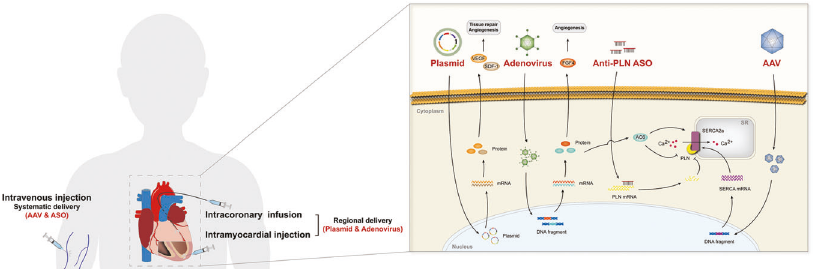
Fig. 5 Summary of therapeutic strategies based on gene therapy for failing hearts. Early attempts were plasmid and adenovirus based. These reagents are usually locally delivered by intracoronary infusion or intramyocardial injection. The overexpressed genes encode secretory protein related to angiogenesis and tissue repair. In one trial, the putative protective adenylyl cyclase type 6 (AC6) was overexpressed. Recent gene therapy trials adopt adeno-associated virus (AAV). A series of clinical trials are designed to overexpress sarco/endoplasmic reticulum Ca 2 + -ATPase 2a (SERCA2a) in cardiomyocytes to improve Ca 2 + handling in heart failure. Modi fi ed RNAs represent a novel approach to target speci fi c genes. It ’ s normally systemically delivered. Although there hasn ’ t been any clinical trial testing RNA therapy for failing heart, preclinical studies using antisense oligonucleotide (ASO) against phospholamban (PLN) showed promising results. AAV: Adeno-associated virus; ASO: antisense oligonucleotide; FGF4: fi broblast growth factor 4; VEGF: vascular endothelial growth factor; SDF-1: stromal cell derived factor-1; SERCA: sarco/endoplasmic reticulum Ca2 + -ATPase; PLN: phospholamban; AC6: Adenylyl cyclase type